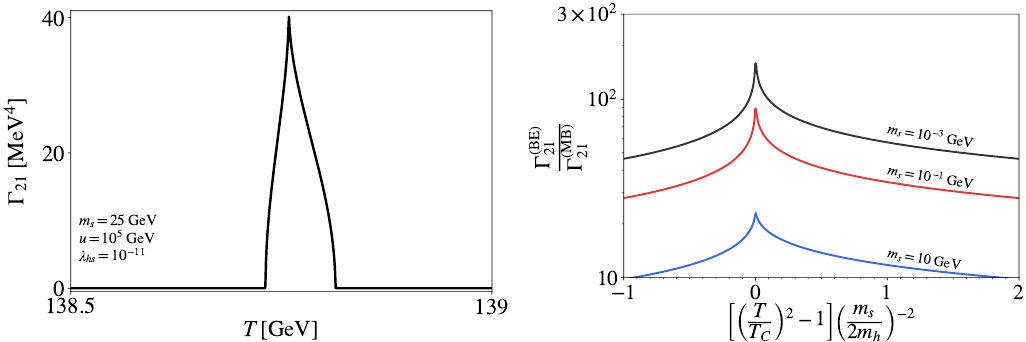
Figure 11 . Left: estimate of the hh ! s reaction rate at the EW crossover with m h ( T c ) = 10 GeV. The s (cid:0) h mixing is set to zero. Right: Bose-Einstein enhancement factor for hh ! s at the 2d order EW phase